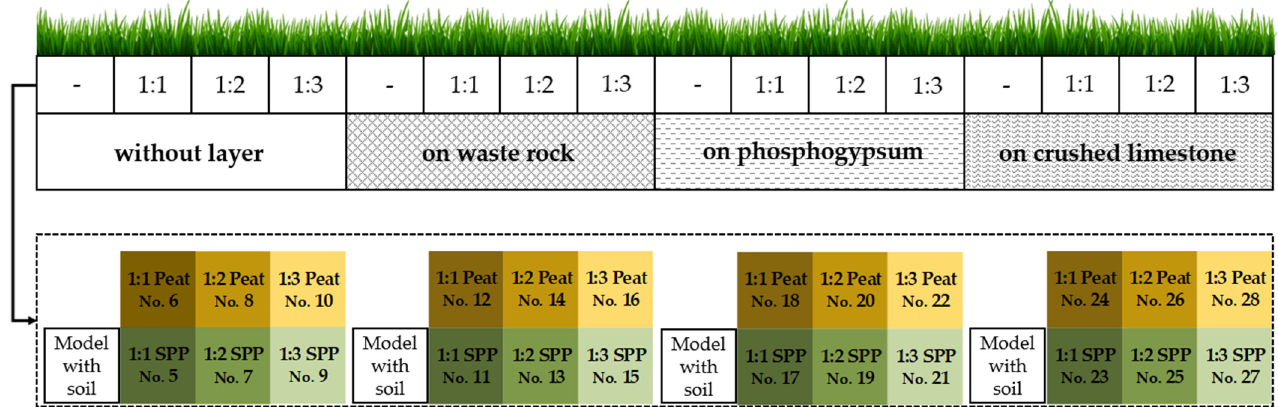
Figure 3. Scheme of the formation of 28 model types with side and top views. Models consist of: A group—control models with soil on different layers, B group—six types of models with different substrates (SPP, peat with soil) and their ratios (1:1, 1:2, 1:3) without a layer for rehabilitation, C group—six types of models on a rehabilitation layer of waste rock, D—six types of models on a rehabilitation layer of phosphogypsum, E—six types of models on a rehabilitation layer of crushed limestone.